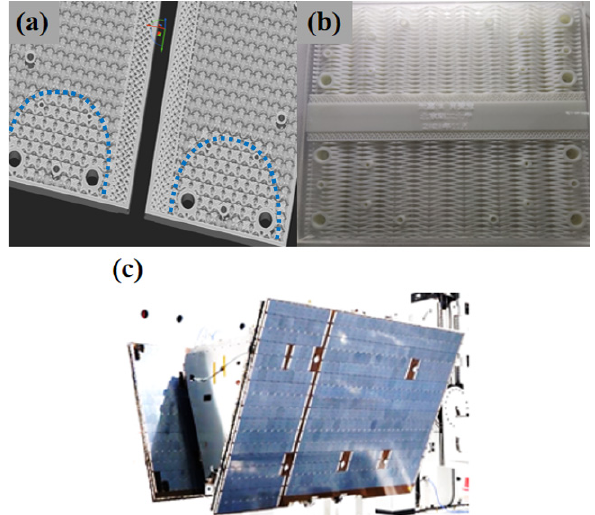
Figure 11. Additive-manufacturing satellite cabin filled with Bambusa-lattice cells: ( a ) load-bearing panel filled with Bambusa-lattice cells; ( b ) multifunctional panel with a thermal control channel and Bambusa-lattice cells; and ( c ) satellite cabin.